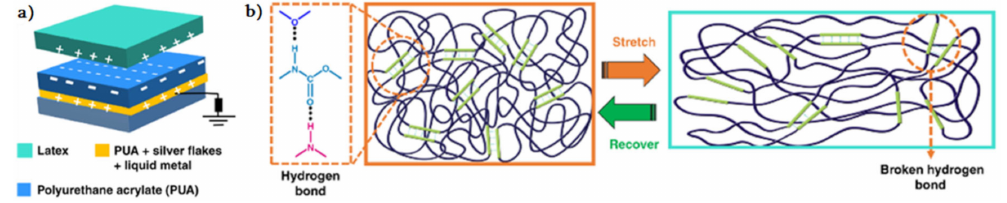
Figure 3. ( a ) Schematic diagram of the complete stack of stretchable and healable TENG and ( b ) a schematic representation of the breaking and reforming of H-bond resulting in high stretchability. Reprinted from [113].